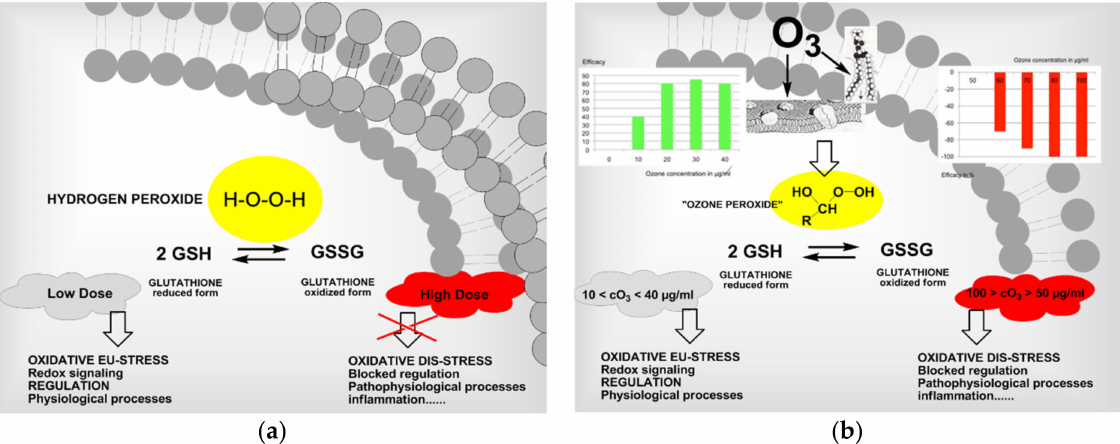
Figure 1. ( a ) Hydrogen peroxide as key redox regulator in the biological system modified acc. to [1,2]. ( b ). Low-dose ozone as